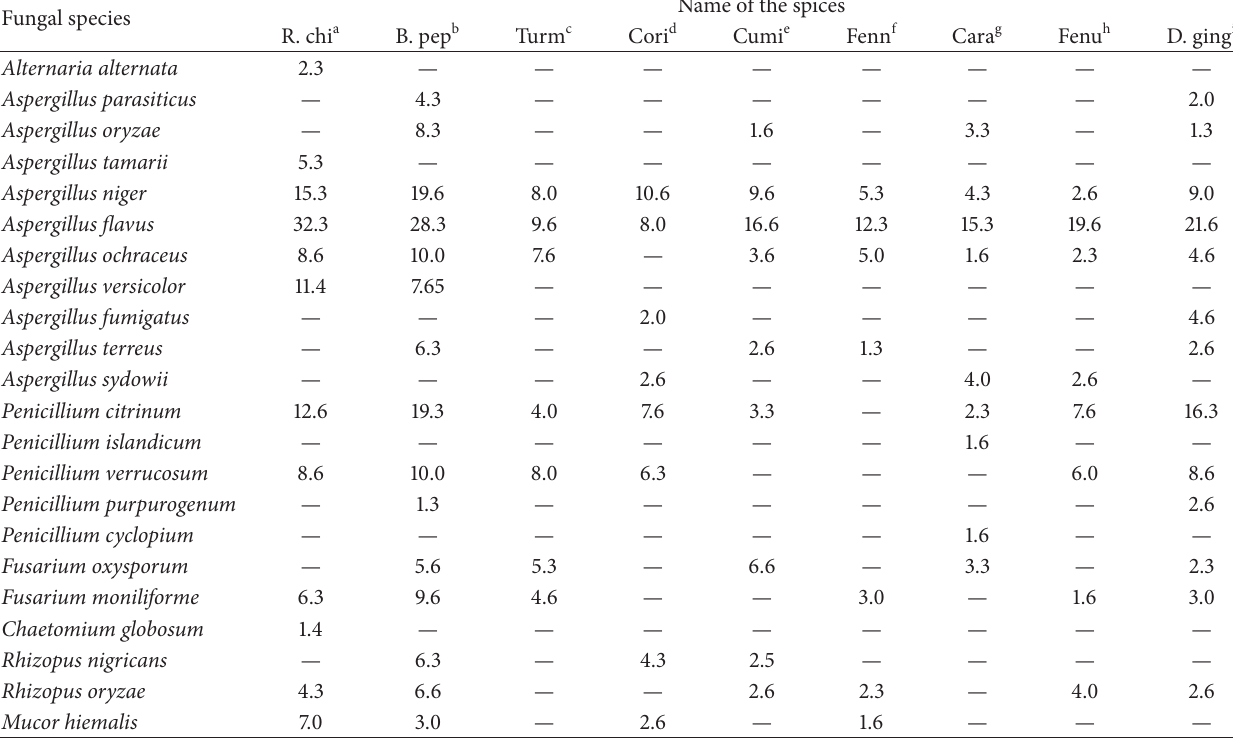
Table 1: Percent incidence of fungal mycoflora isolated from different spices.